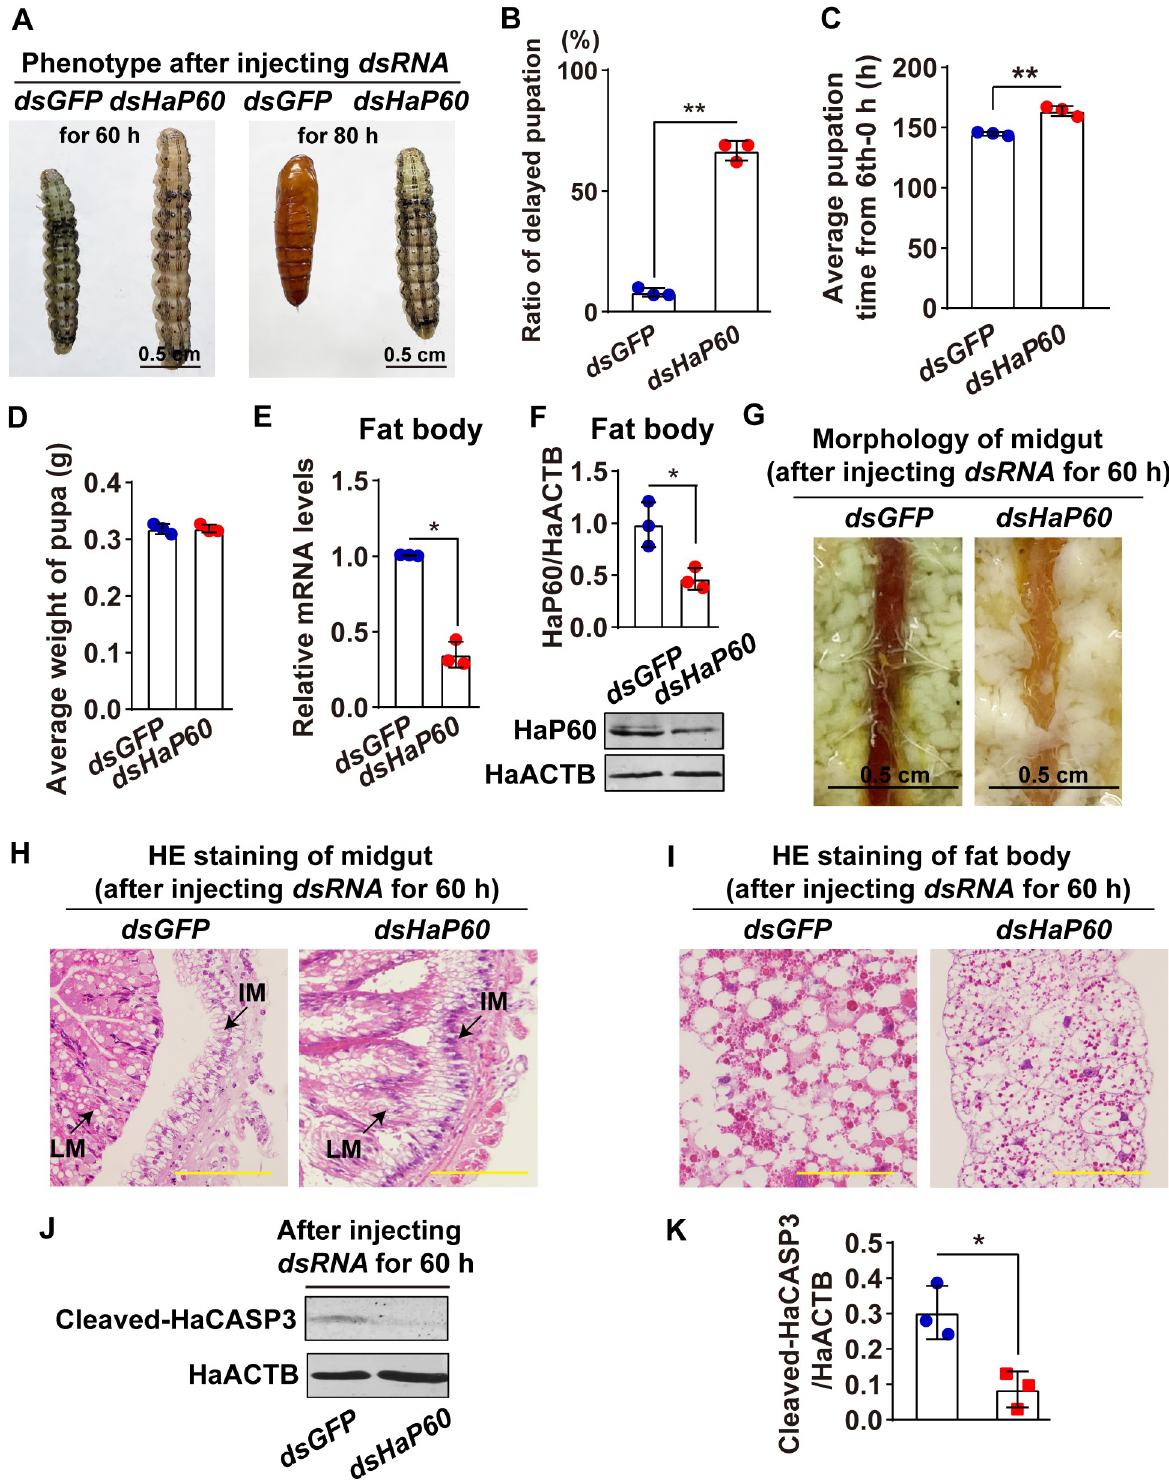
Fig 8. HaP60 knockdown by injecting dsRNA at the wandering stages delayed metamorphosis. A. Phenotype analysis after first injecting dsRNA for 60 h and 80 h. Bar, 0.5 cm. B. Statistical analysis of the delayed pupation in A by Student’s t -test based on three repeats. Thirty larvae for each repeat. C. Statistical analysis of pupation time from 6th-0 h to pupa 0 d after HaP60 knockdown. D. The average weight of pupa after HaP60 knockdown. Thirty larvae for each repeat. E and F. Efficiency analysis of HaP60 knockdown using qRT-PCR and western blotting at the mRNA